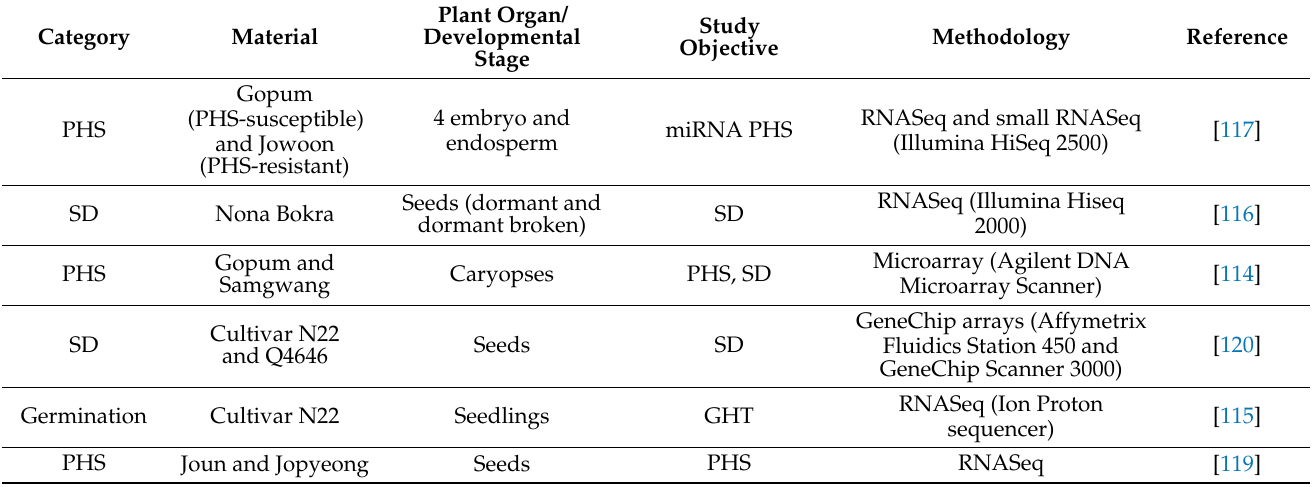
Table 2. Application of next-generation sequencing technologies on pre-harvest sprouting in